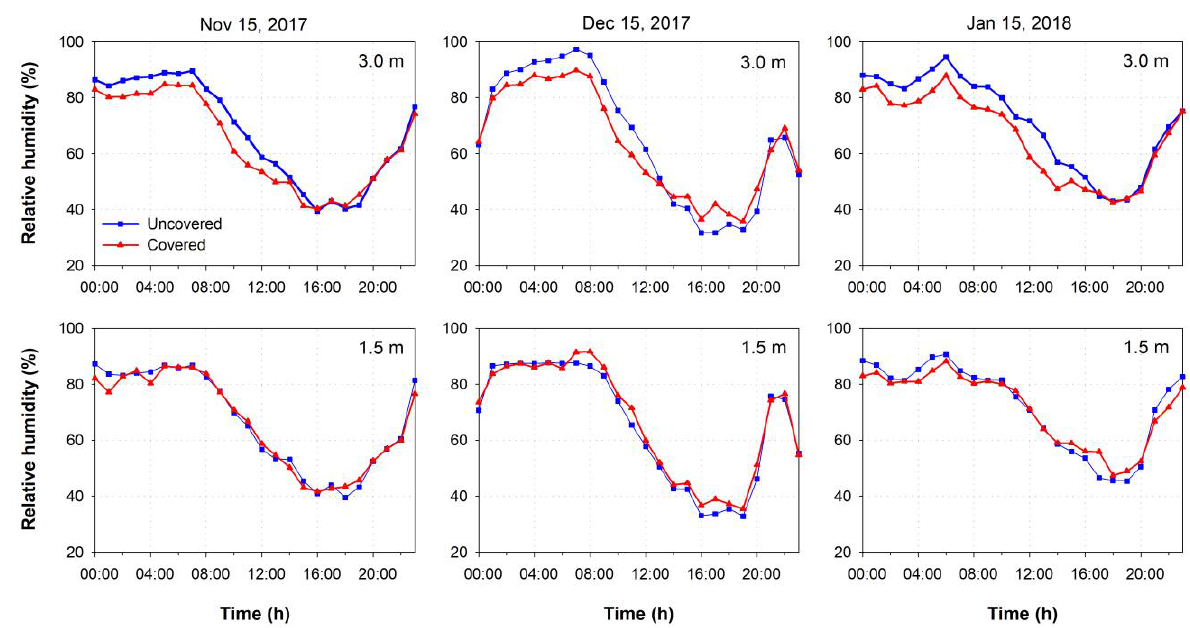
Figure 3. Daily fluctuation of relative humidity with and without rain cover at 3 m ( top ) and 1.5 m ( bottom ) above the ground. Days evaluated under cloudless conditions. Central Valley, Chile. From 1 November to 15 December 2017, the daily maximum temperatures at a 3 m height were higher under rain cover, but not at 1.5 m. On the other hand, thermal